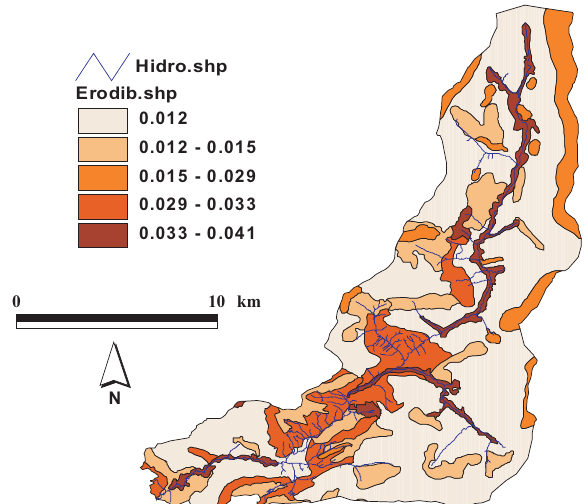
Figura 6. Mapa da erodibilidade dos solos da bacia do rio Pipiripau. As coordenadas UTM nas extremidades da bacia são de 8.289.876 e 8.264.635 (N-S) e 235.842 e 213.790 (E-W).